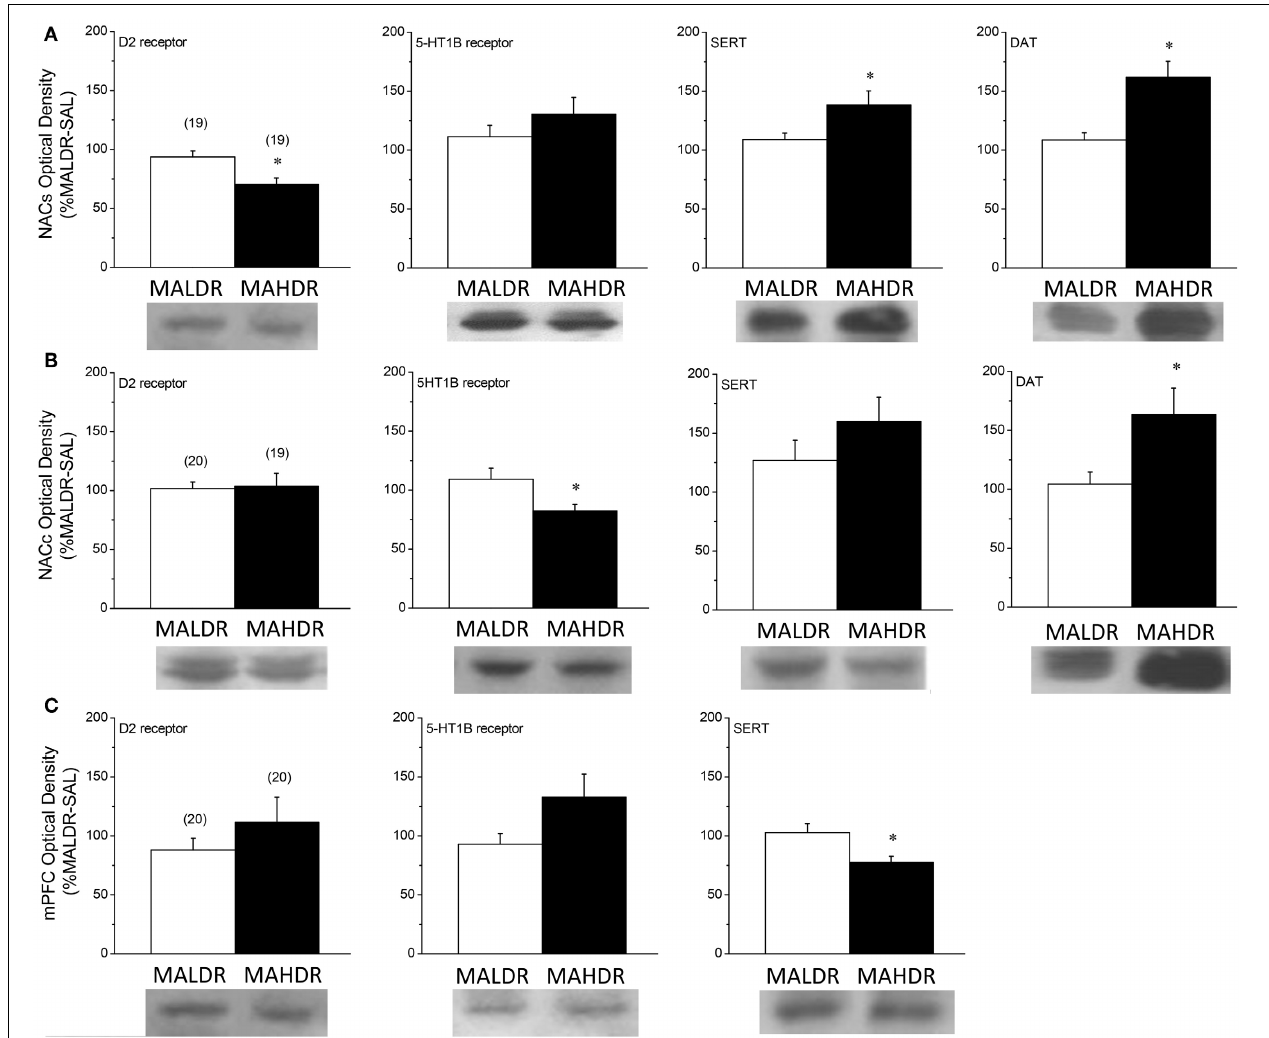
FIGURE 8 | Comparison of protein expression within the nucleus accumbens shell (NACs) (A), the nucleus accumbens core (NACc) (B) and the medial prefrontal cortex (mPFC) (C) for the D2 dopamine receptor, the dopamine transporter (DAT), the 5HT1B receptor and the serotonin transporter (SERT) of genetically heterogeneous B6 × D2 mice (F2B6D2) and mice selectively bred for high vs. low MA intake (MAHDR